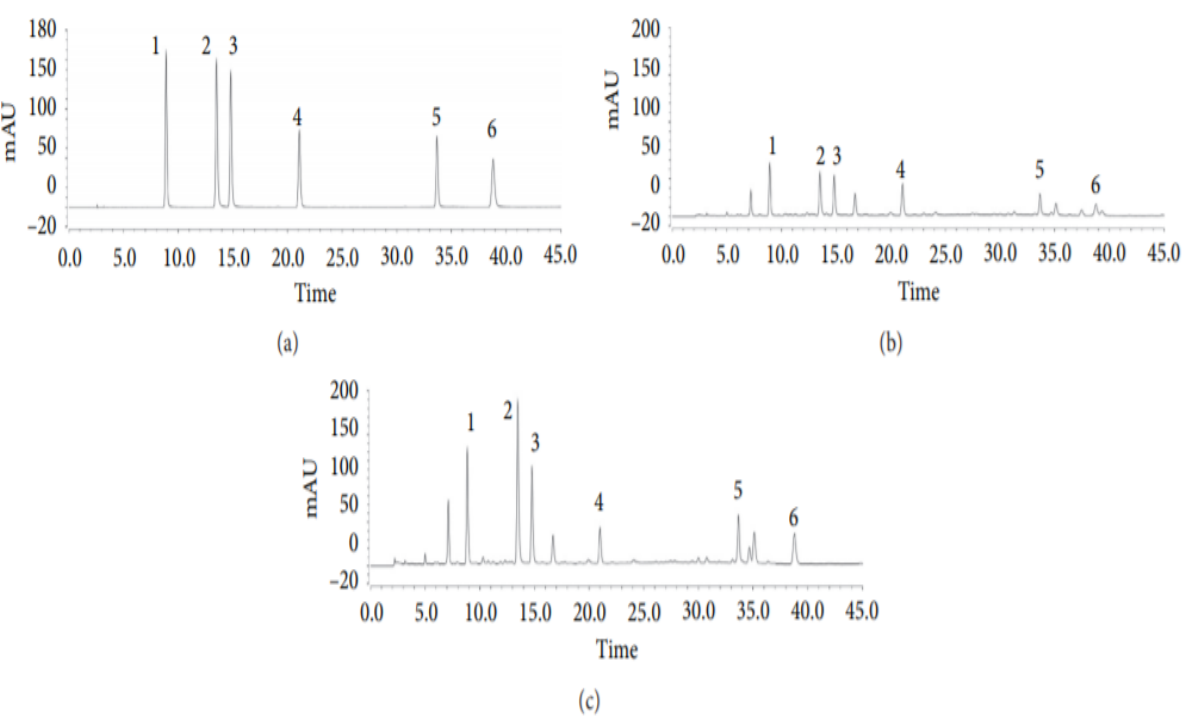
Figure 4. Representative HPLC chromatograms of ( a ) mixed standards; ( b ) A. capillaris herb; ( c ) A. capillaris decoction. Each numerical number signifies respective compounds: (1) 5-Caffeoylquinic acid; (2) 3-caffeoylquinic acid; (3) 4-caffeoylquinic acid; (4) 1,3-dicaffeoylquinic acid; (5) 3,4-dicaffeoylquinic acid; (6) 4,5-dicaffeoylquinic acid [40].